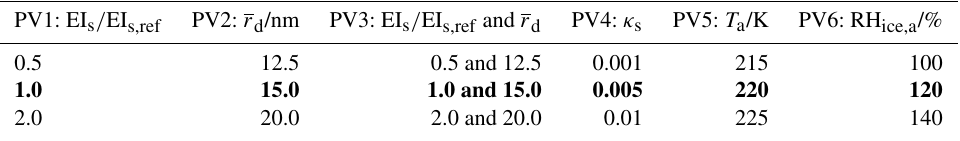
Table 2. Parameter variations (PVs) of various soot properties and ambient conditions. The values in bold depict the default baseline parameter, and EI s,ref is the baseline soot number emission